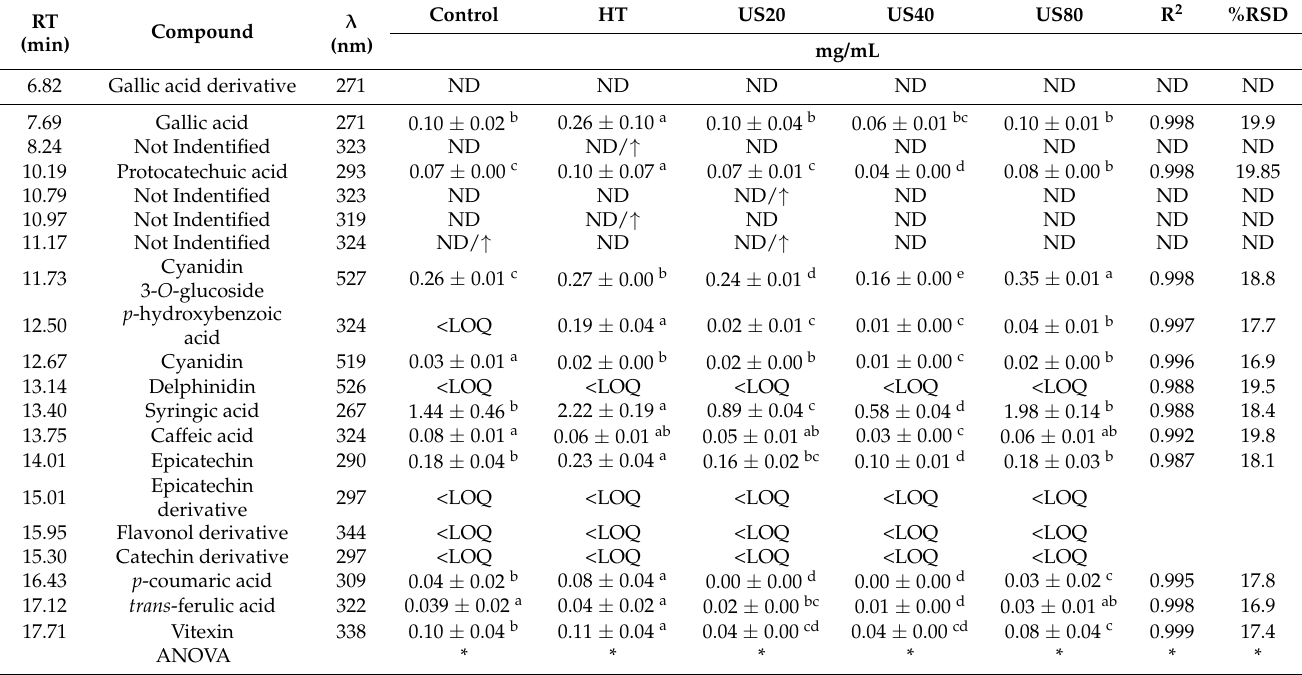
Table 4. Phenolic compound quantified and tentatively identified in Amazon fig